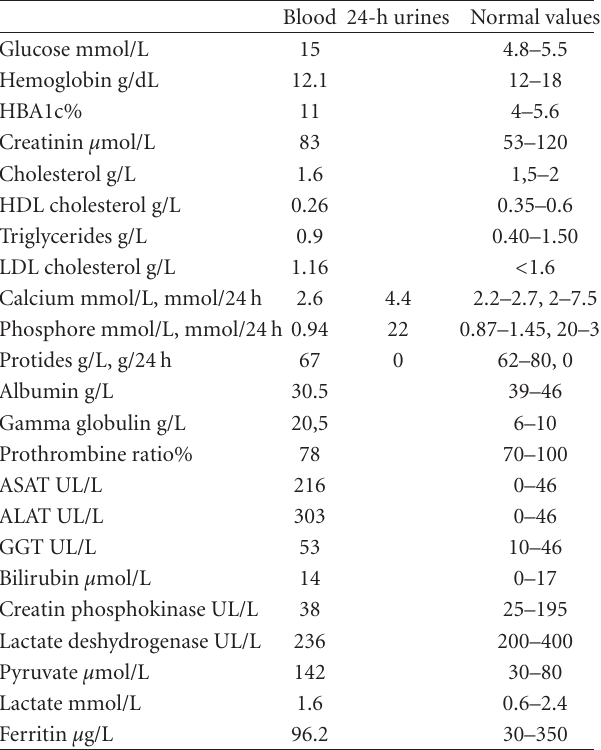
(Figure 5) and cataract. Muscular biopsy with enzymatic study, electroencephalogram, and MRI of brain were normal. Electromyogram showed signs of axonal type minor to mod- erate neurogenic damage of lower limbs. X-ray film of the left wrist showed radioulnar synostosis. There was a